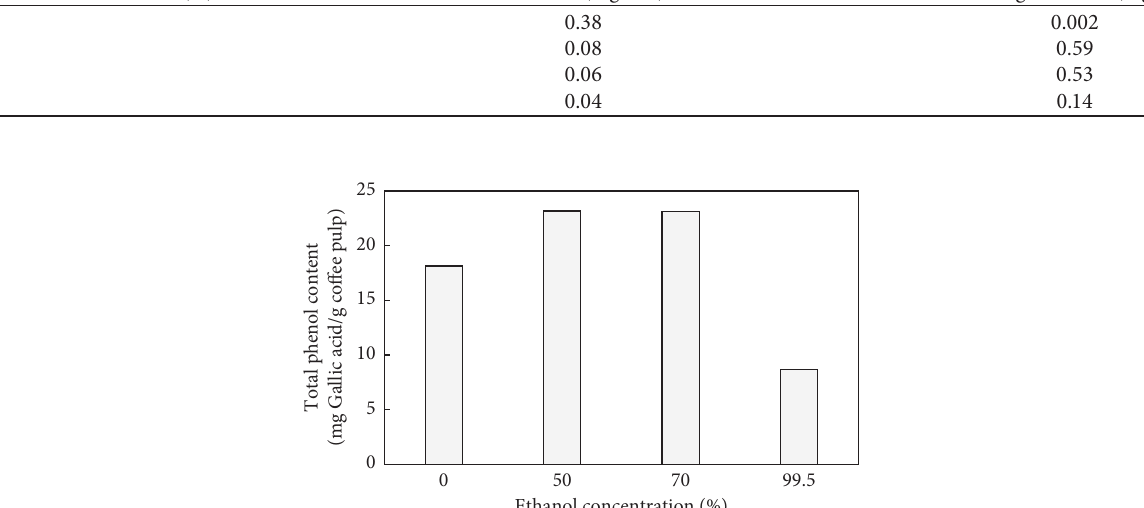
Table 1: Caffeine and chlorogenic acid content of the coffee pulp extracts obtained using different ethanol concentrations. Ethanol concentrations (%)